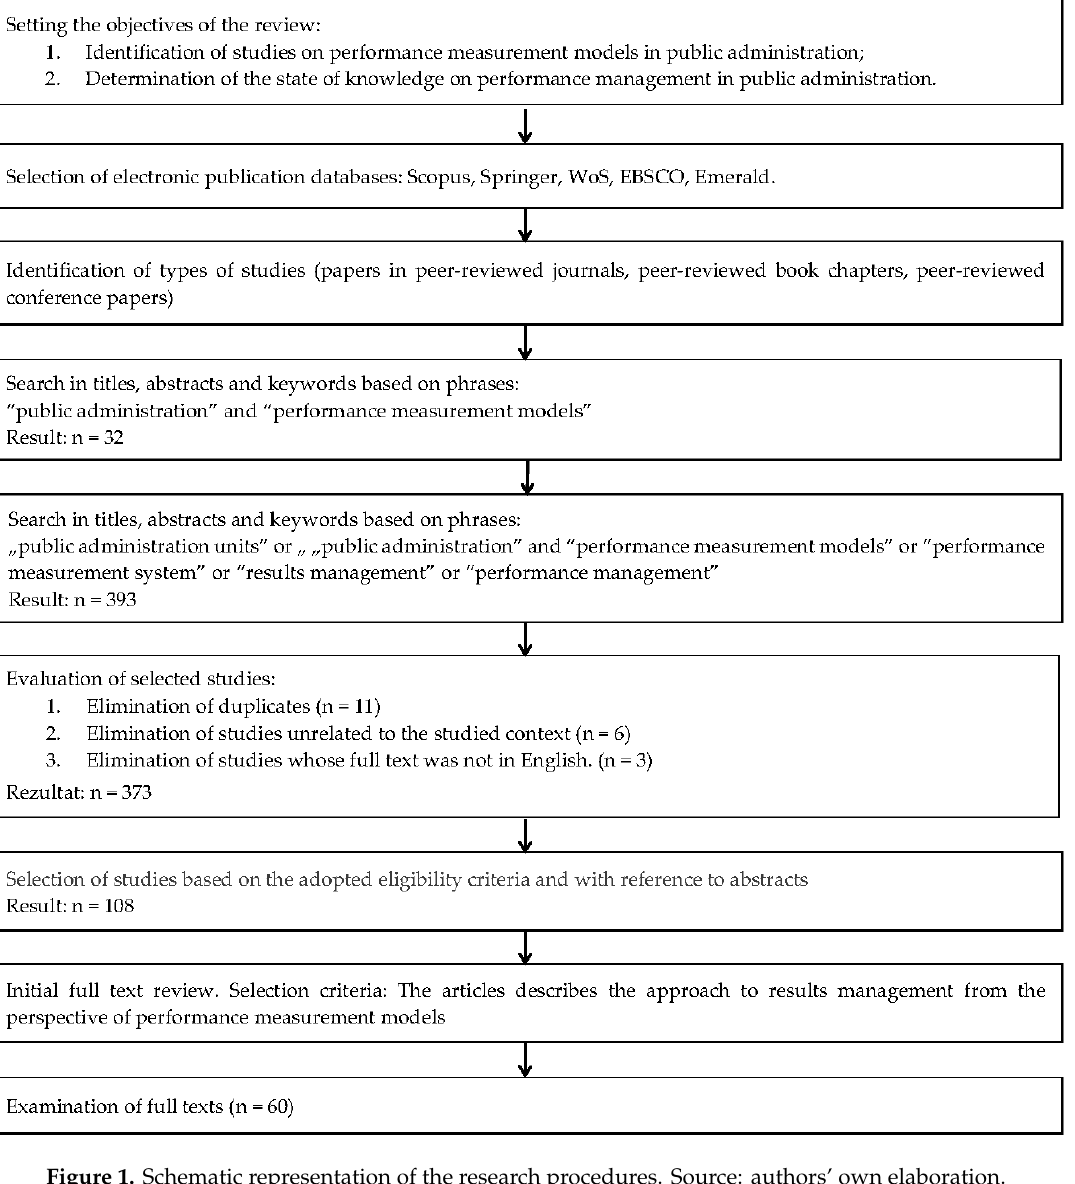
Figure 1. Schematic representation of the research procedures. Source: authors’ own elaboration.